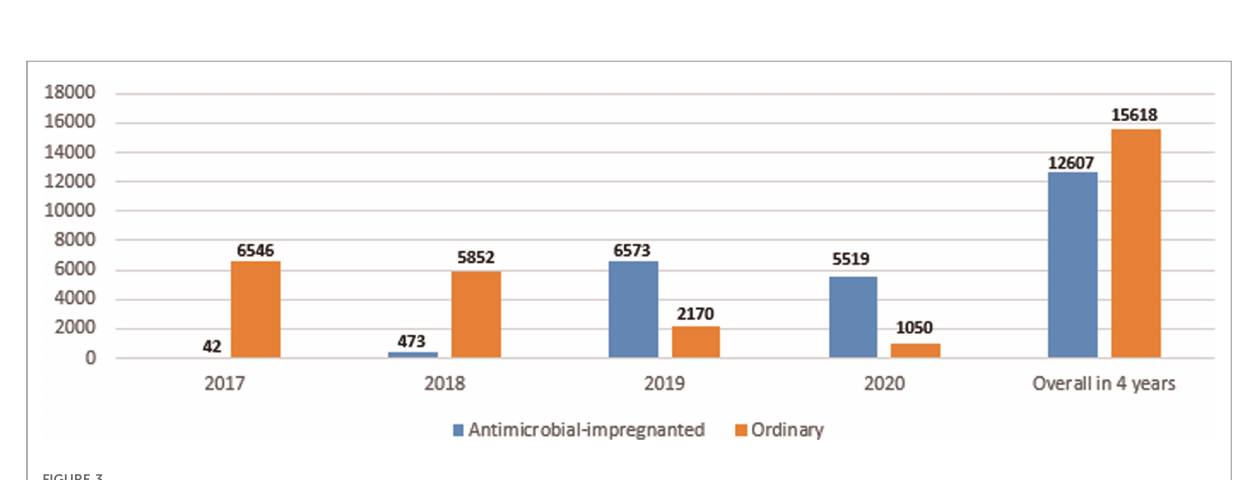
FIGURE 3 Dwell time in days between the two types of catheters across the 4